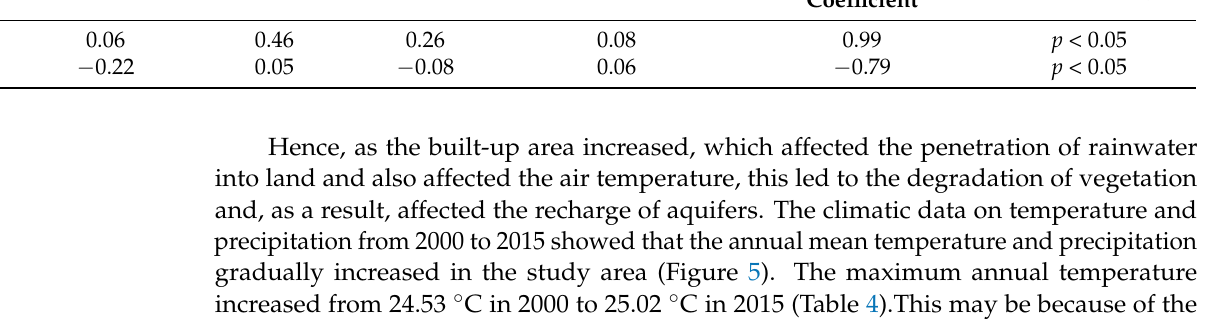
Table 3. Statistics of land-use indices and their correlation with depth to water table (DWT). Statistics of NDVI and NDBI